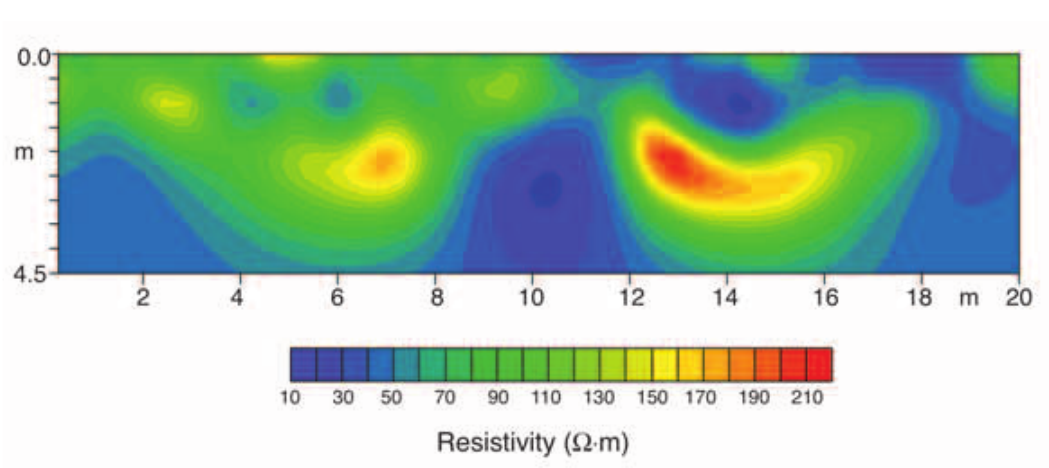
Fig. 6. Geoelectrical profile (along magnetic anomaly A, fig. 4a) showing a low resistivity area between two high resistivity